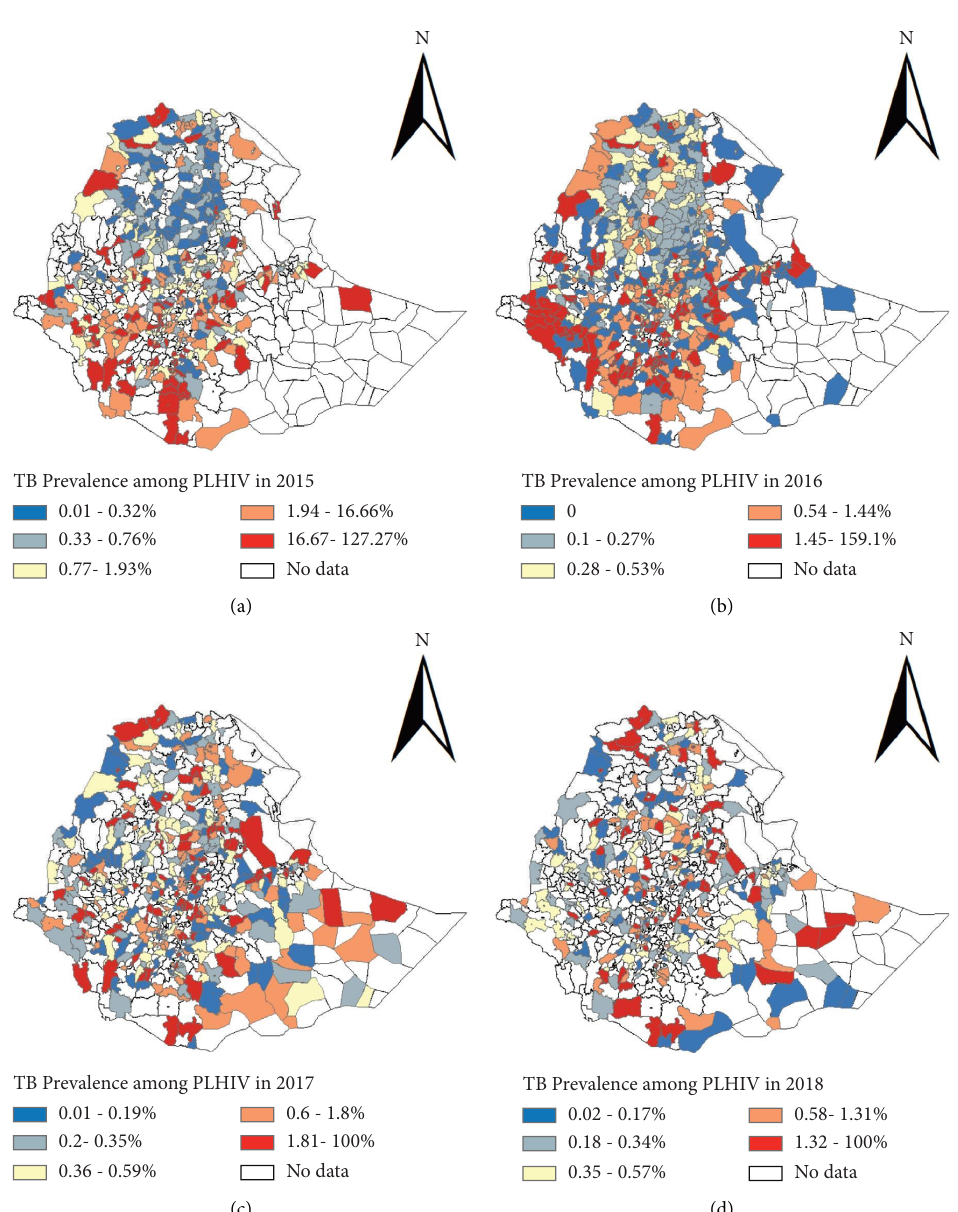
Figure 3: Geographical distribution of the prevalence of tuberculosis among people living with HIV in Ethiopia in (a) 2015, (b) 2016, (c) 2017, and (d)